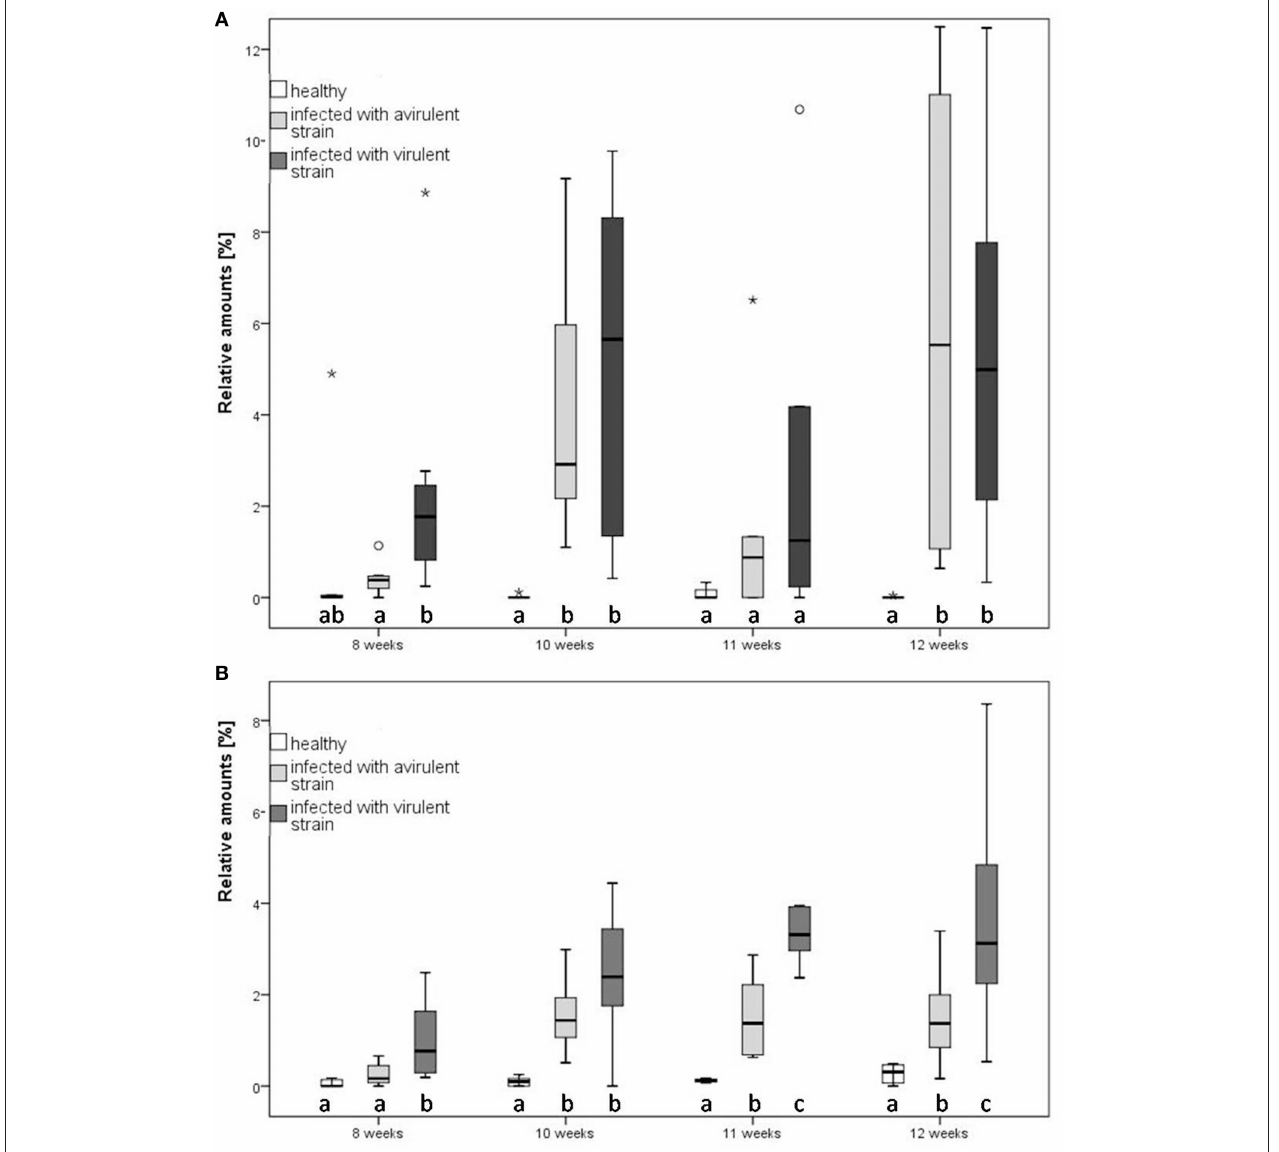
FIGURE 4 | Relative amounts of two compounds of tobacco ( Nicotiana occidentalis ) at three plant infection conditions at different infection states in direct comparison. (A) Ethyl benzoate, (B) sesquiterpene 23.4. Different letters indicate statistical differences (Mann-Whitney, p < 0.05 , followed by Bonferroni-Holm correction). Notice that outliers are indicated by circles and extremes by asterisks. The relative amounts of emitted ethyl benzoate and ST 23.4 are at every time point higher in the infected plants, compared to healthy